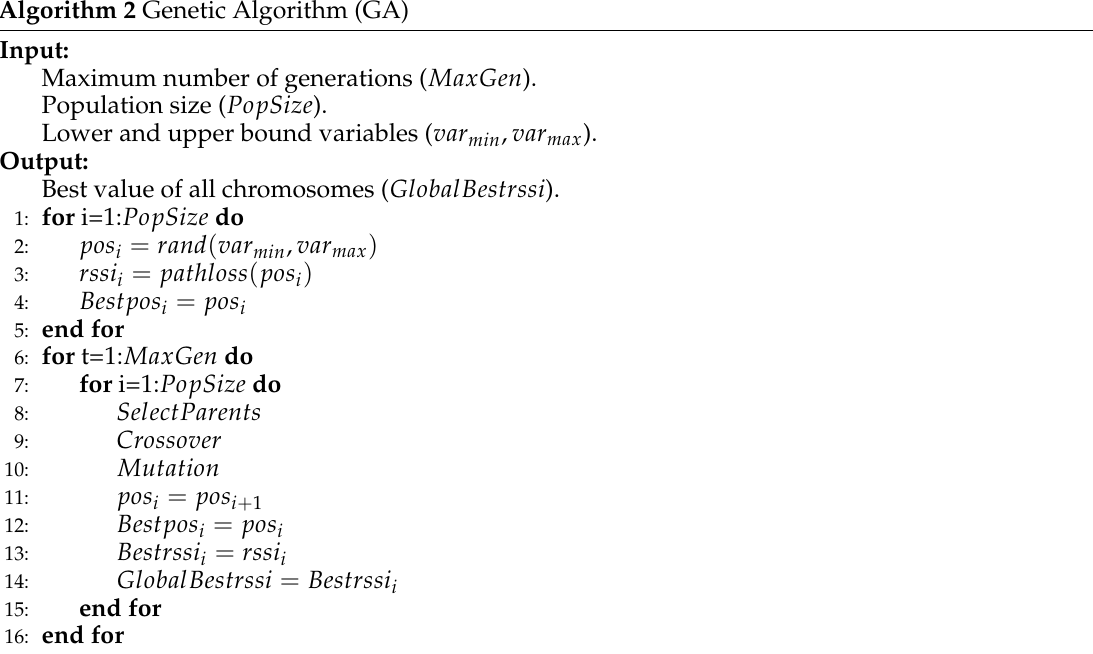
Algorithm 2 Genetic Algorithm